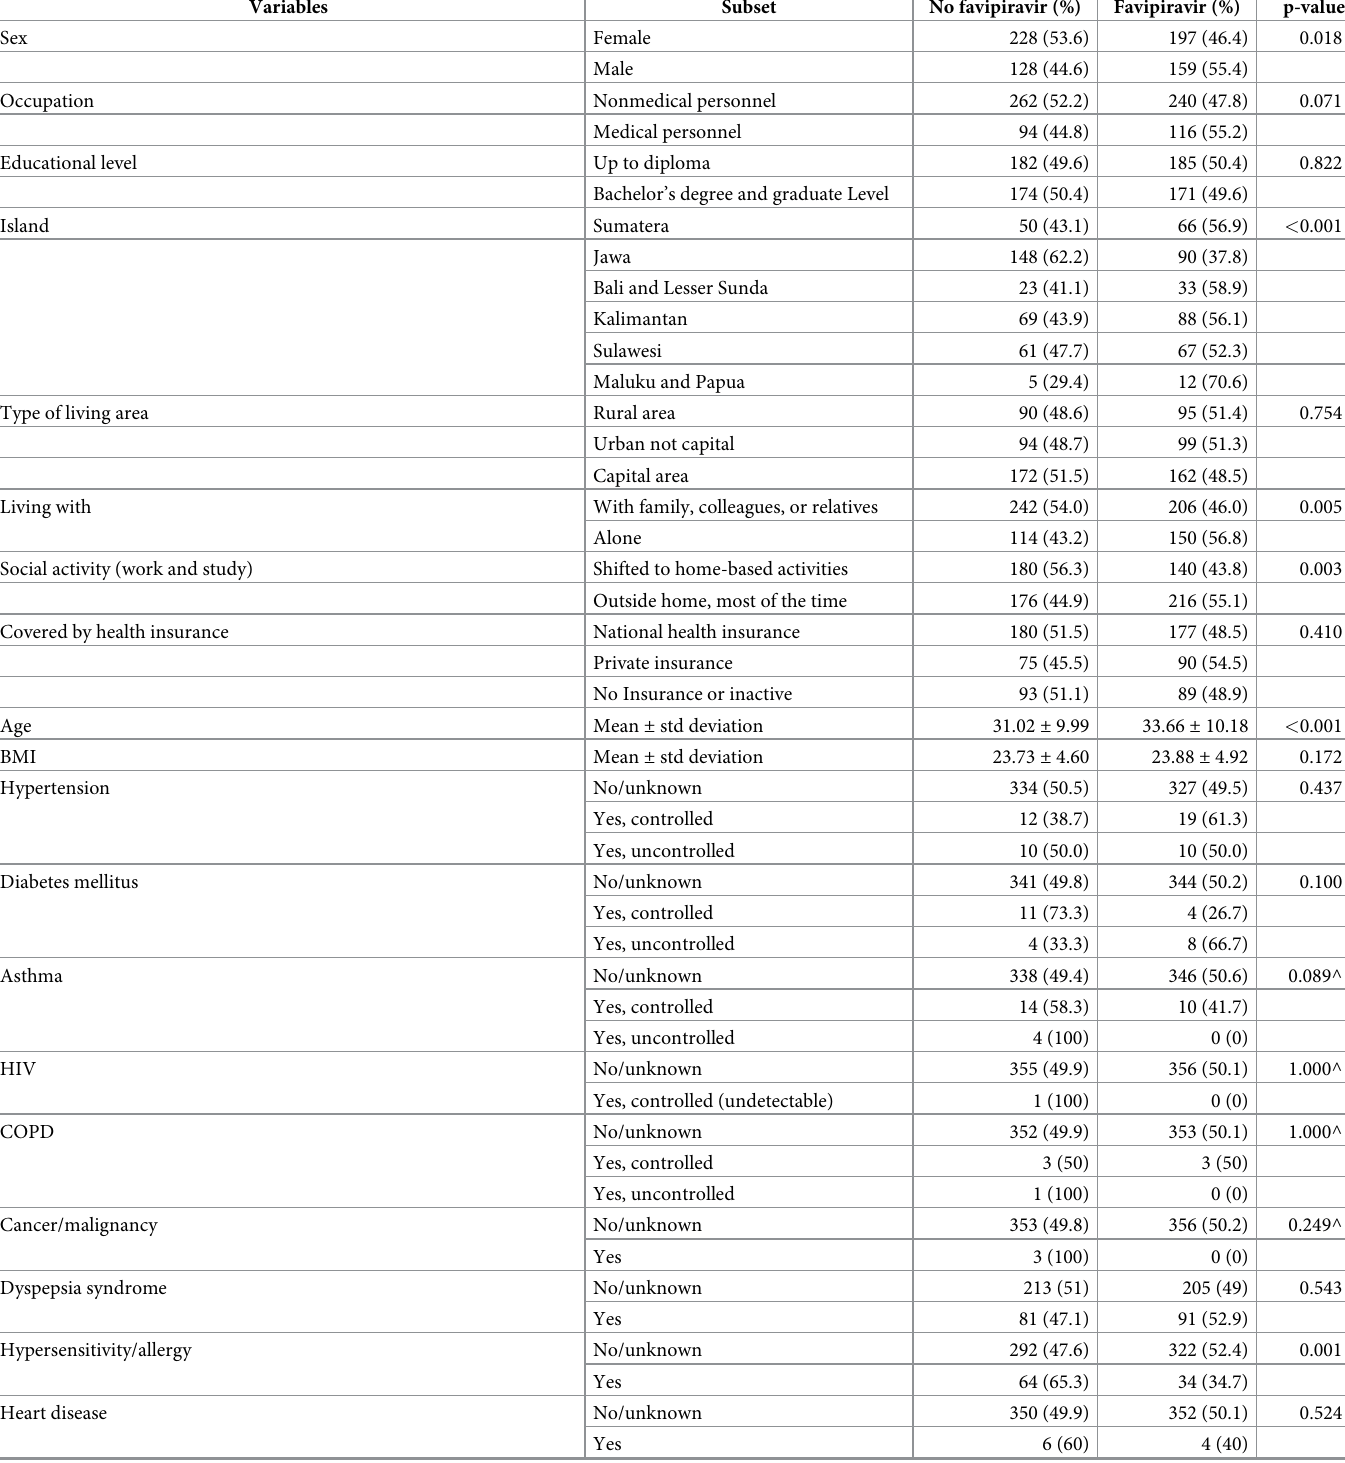
Table 1. Demographic characteristics of participants (n =